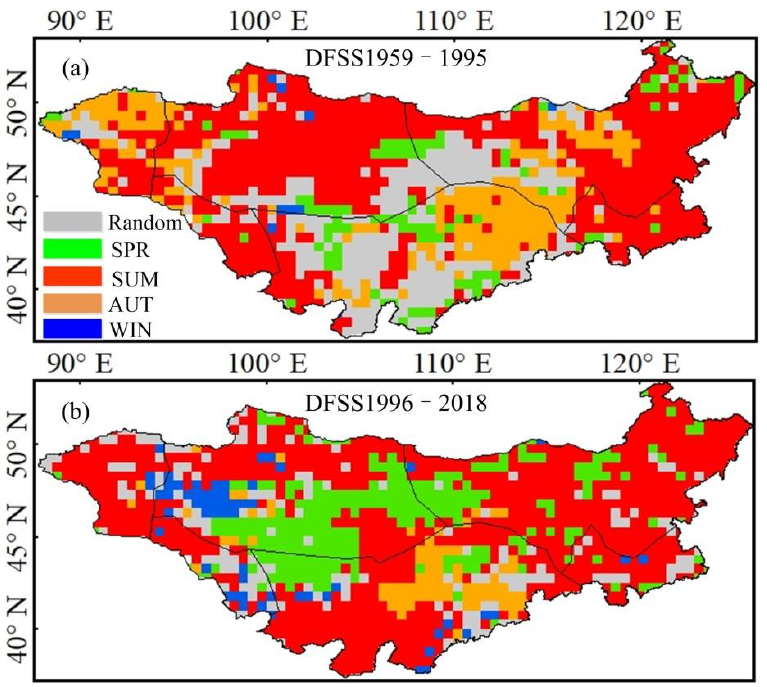
Figure 9. Spatial pattern of the DFSS of the drought events in the periods of ( a ) 1959–1995 and ( b